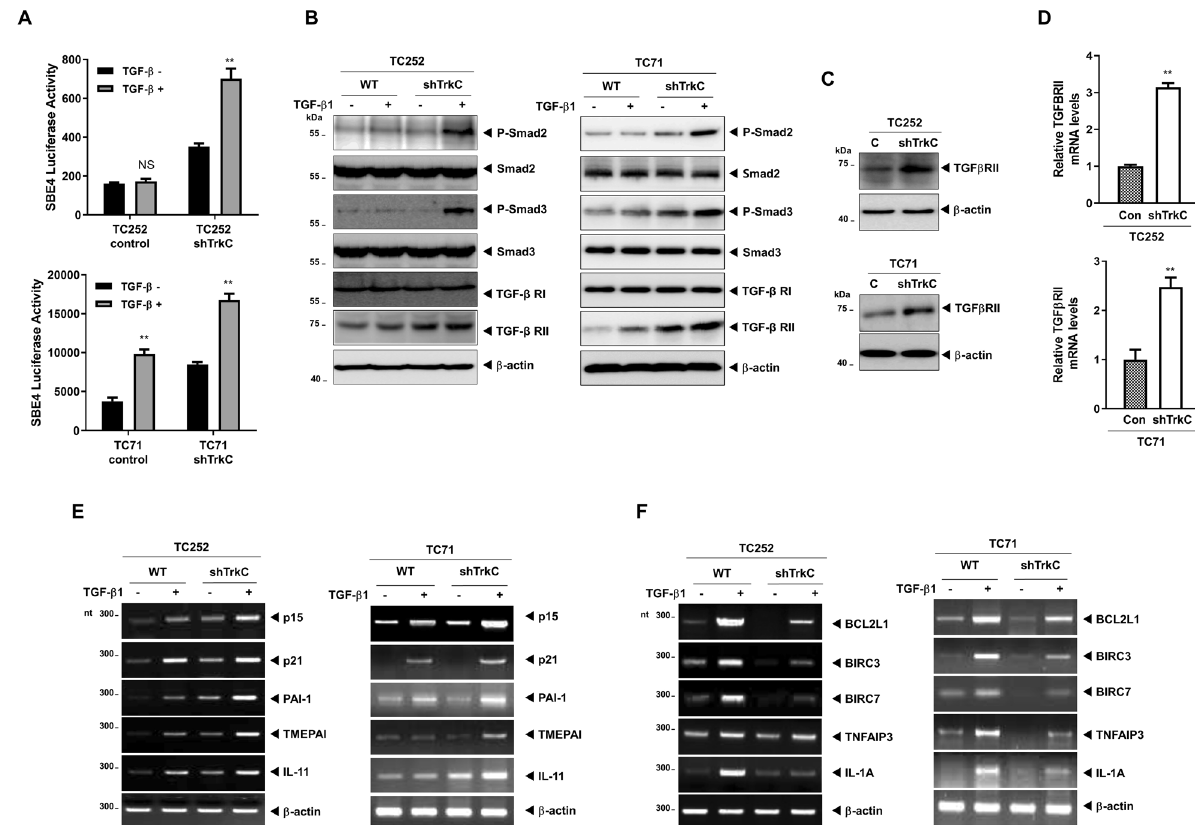
Fig. 5 TrkC inhibited TGF- β -mediated tumor suppressor activity. A The activity of TGF- β 1-responsive SBE luciferase reporter in TC252 and TC71 control-shRNA or TrkC-shRNA cells. Luciferase activity was measured at 24 h after treatment with TGF- β 1 (5 ng/mL). n = 3. P values < 0.05 (**); t test, NS: Not signi fi cant. B Immunoblot analysis of the expression of phospho-SMAD2, phospho-SMAD3, SMAD2, SMAD3, TGF- β type I or II receptors in TC252 and TC71 control-shRNA or TrkC-shRNA cells after stimulation with TGF- β 1 (5 ng/mL). β -actin was used as a loading control. C Immunoblot analysis of the expression of TGF- β type II receptor in TC252 and TC71 control-shRNA or TrkC-shRNA cells. β -actin was used as a loading control. D Quantitative RT-PCR analyses of TGF- β type II receptor in TC252 and TC71 control-shRNA or TrkC-shRNA cells. The 18S was used for loading control. n = 3. P values < 0.05 (**); t test. E RT-PCR analyses of p15 Ink4b , p21 Cip1 , PAI1, TMEPAI, and IL-11 mRNAs in TC252 and TC71 control-shRNA or TrkC-shRNA cells after treatment with or without TGF- β 1 (5 ng/mL). β -actin was used as a loading control. F RT-PCR analyses of BCL2L1, BIRC3, BIRC7, TNFAIP3, and IL-1A mRNAs in TC252 and TC71 control-shRNA or TrkC-shRNA cells after treatment with or without TGF- β 1 (5 ng/mL). β -actin was used as a loading